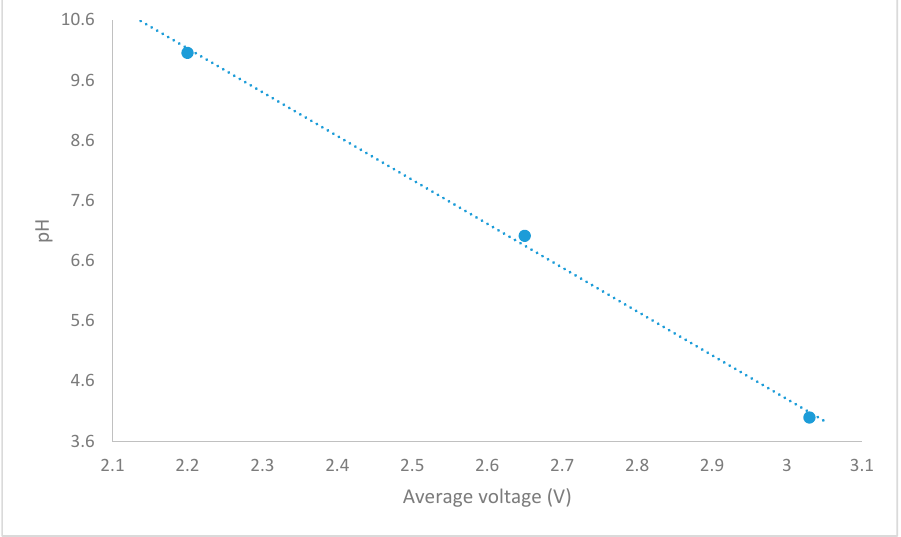
Figure 7. Relationship between pH and voltage.